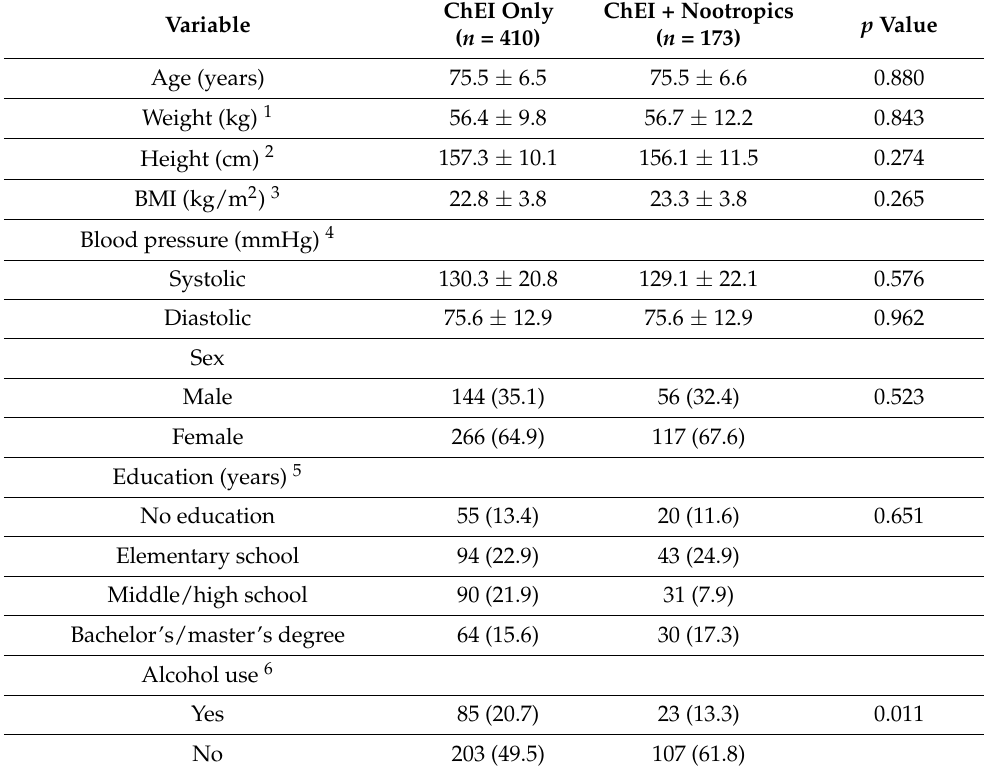
Table 1. Demographic and clinical characteristics of the cholinesterase inhibitor only group and the nootropics combination